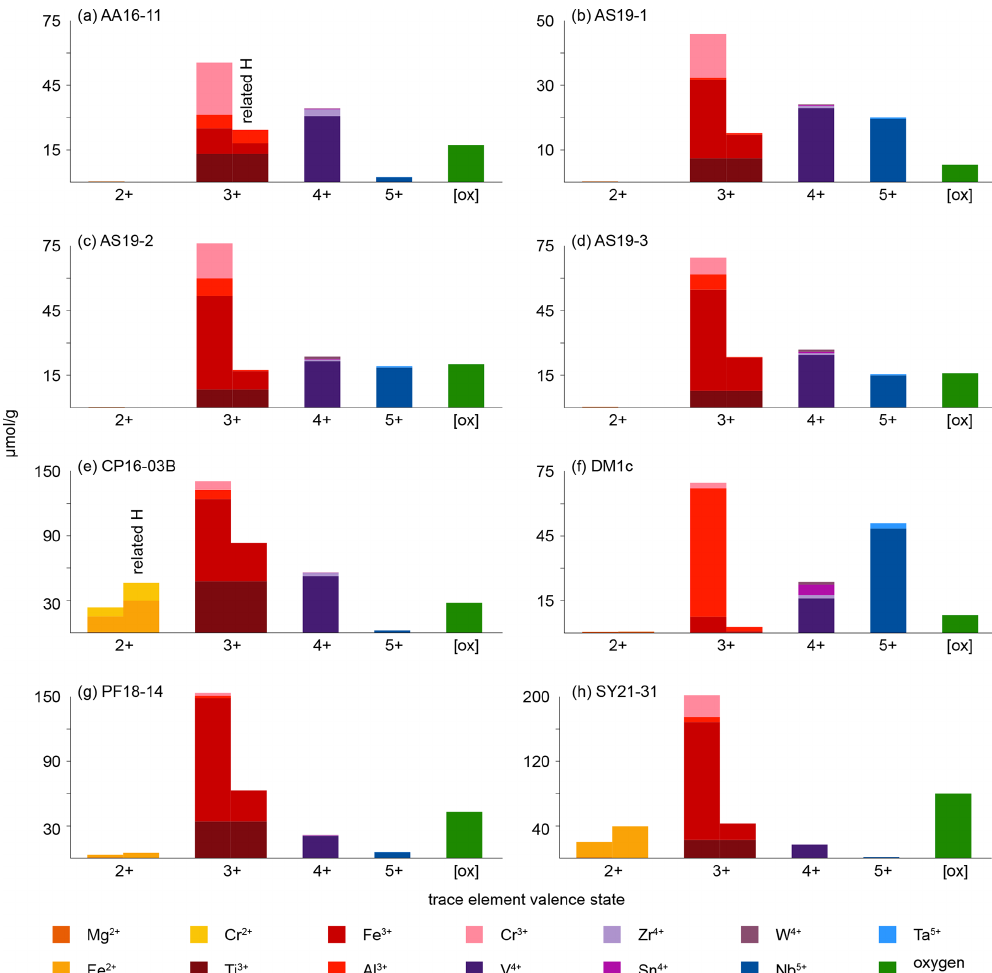
Figure 9. Molar trace-element contents (µmolg − 1 ) by valence state. Each bar represents all trace elements with the same valence state. For di- and trivalent cations, the left column depicts the trace-element content and the right column the trace-element-related H + content. Cations that create a charge deficit are shown in orange and red, cations that create a charge surplus in blue, and cations that do not influence charge balance in violet. Oxygen vacancies are calculated from total excess of di- and trivalent cations over pentavalent cations. It is assumed that Cr occurs as Cr 2 + when Cr-related OH bands are visible and as Cr 3 + otherwise; V is considered to occur purely as V 4 + ; V 3 + and V 5 + are not considered. Ti 3 + is given as minimum values, assuming coupling only with H + and not pentavalent cations. For Fe and Cr, it is assumed that if Cr 2 + and/or Fe 2 + are present, they are completely charge balanced by H + and H + , respectively, while Cr 3 + and ( Fe 2 + ) ( Cr 2 + ) Fe 3 + are calculated as Cr total − Cr 2 + and Fe total − Fe 2 + . Any charge surplus from di- and trivalent cations that is not charge balanced by H + or pentavalent cations is assumed to be balanced by oxygen vacancies, with one oxygen vacancy balancing two trivalent cations. Data can be found in Table